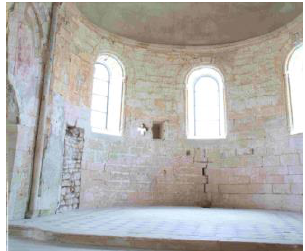
Figure 8. Cylindrical choir of the Nativité-Notre-Dame church, Dugny s/ Meuse,